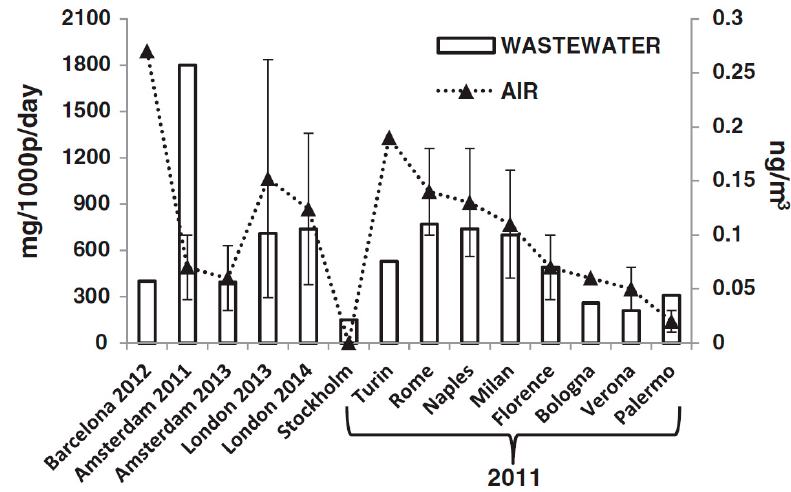
Figure 3. Average air concentrations of cocaine in various European cities and their estimated drugs abuse levels obtained from wastewater investigations from same year. With permission [45]